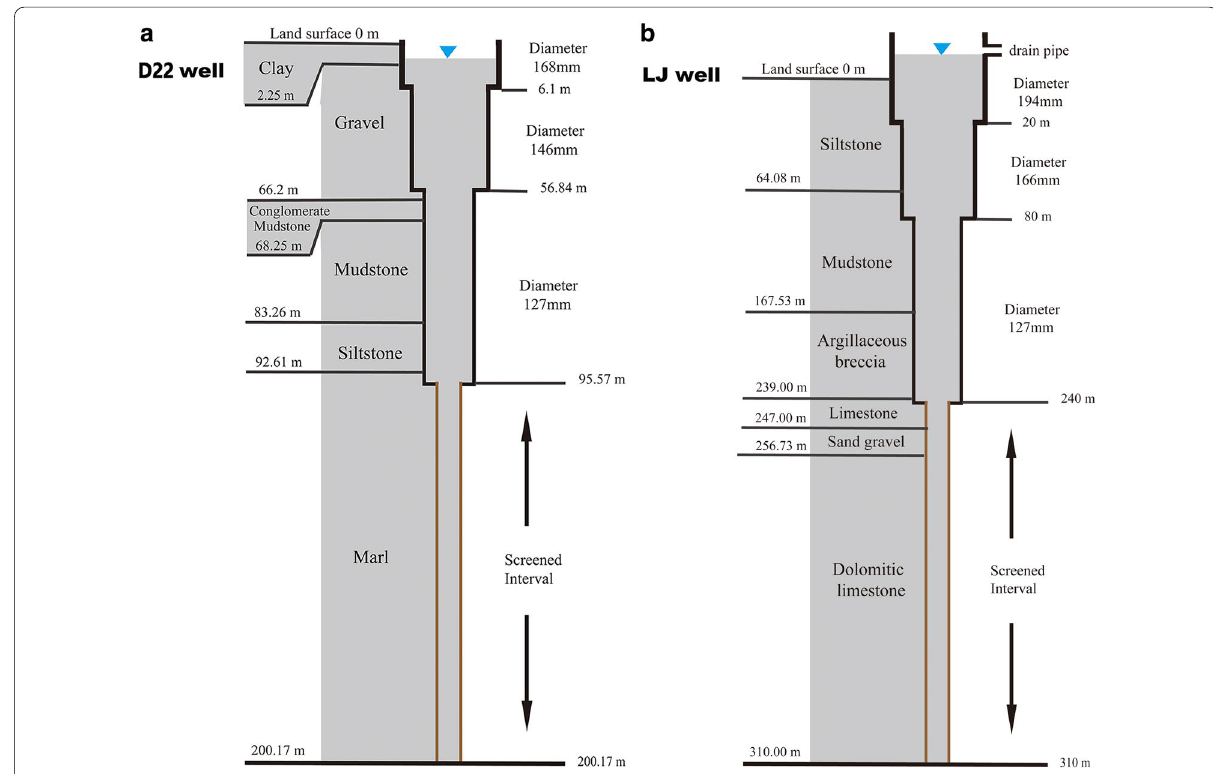
Fig. 2 Wellbore structure and lithology of the D22 well ( a ) and LJ well ( b )